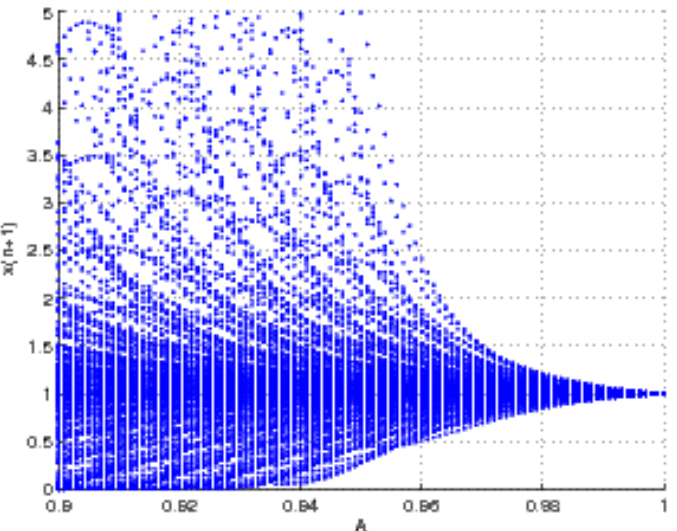
Figure 2. Neimark–Sacker bifurcation of the map x n + 1 = Bx n + x n − 4 can see that chaos shifted to stability at point A =